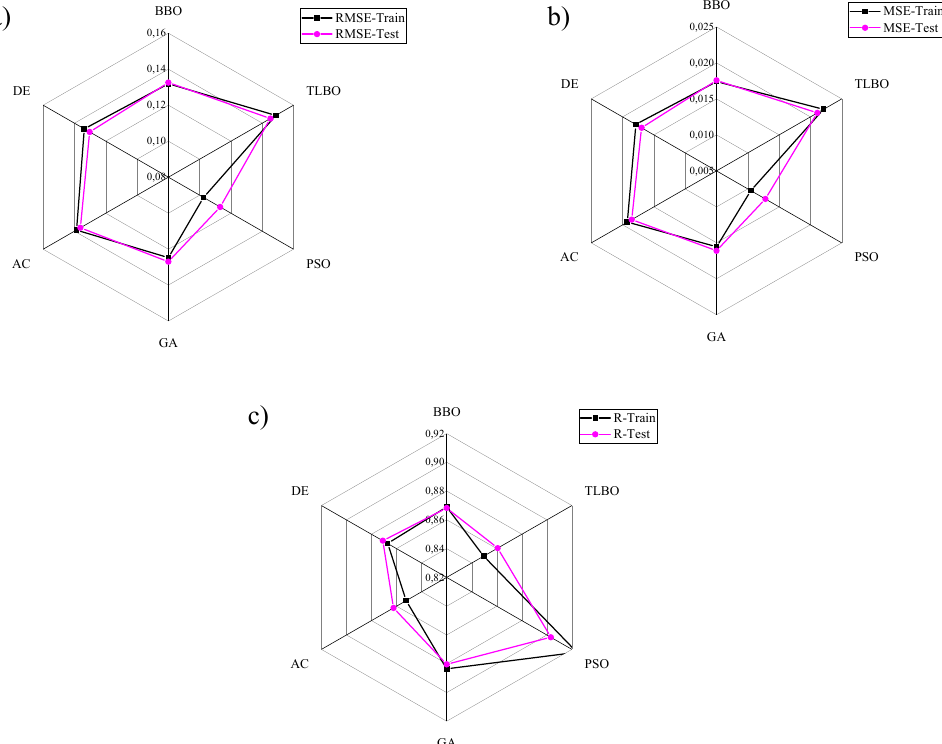
Figure 20. Comparison of the statistical indicators for six evolutionary algorithms to predict the steam generation, ( a ) RMSE, ( b ) MSE, and ( c ) R.